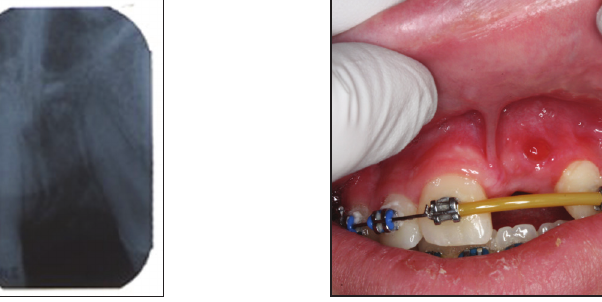
Figure 4. LCPA radiograph focussed on upper left permanent central incisor region demonstrating residual dental hard tissue and radio-opaque material.